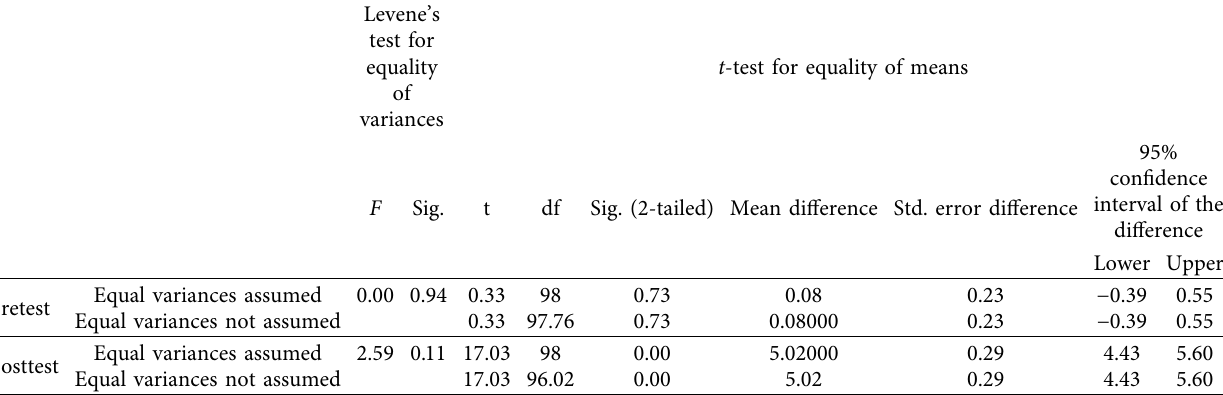
Table 2: Results of independent-samples t -test comparing the pretest vocabulary and posttest vocabulary scores. Levene’s test